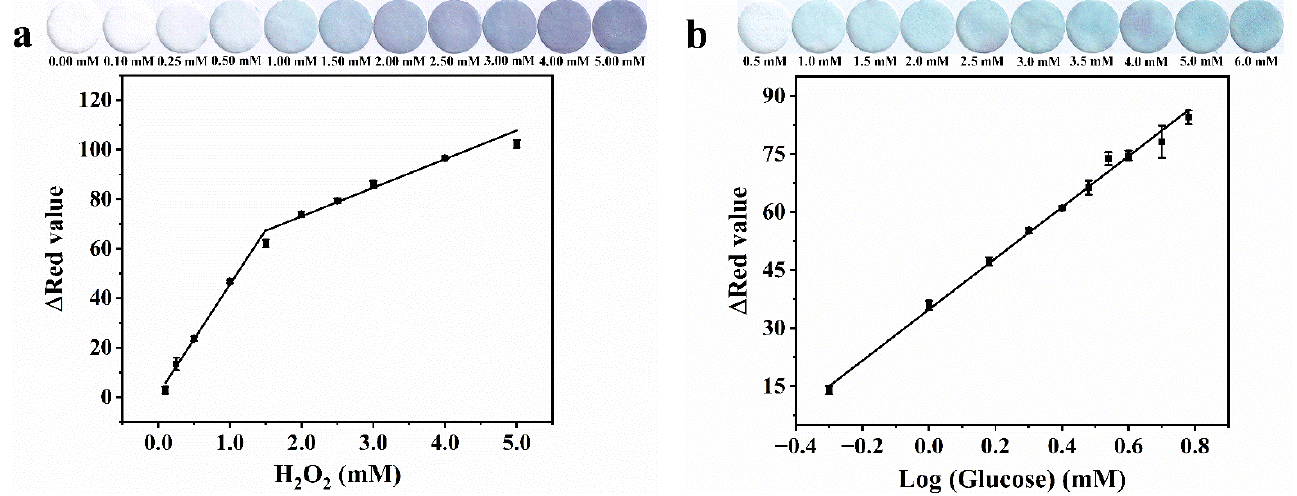
Figure 5. Calibration curves for the determination of H 2 O 2 ( a ) and glucose ( b ) by the paper device under the optimal conditions, respectively. Table 1. Determination of H 2 O 2 using paper device and compared the results with other reported methods.